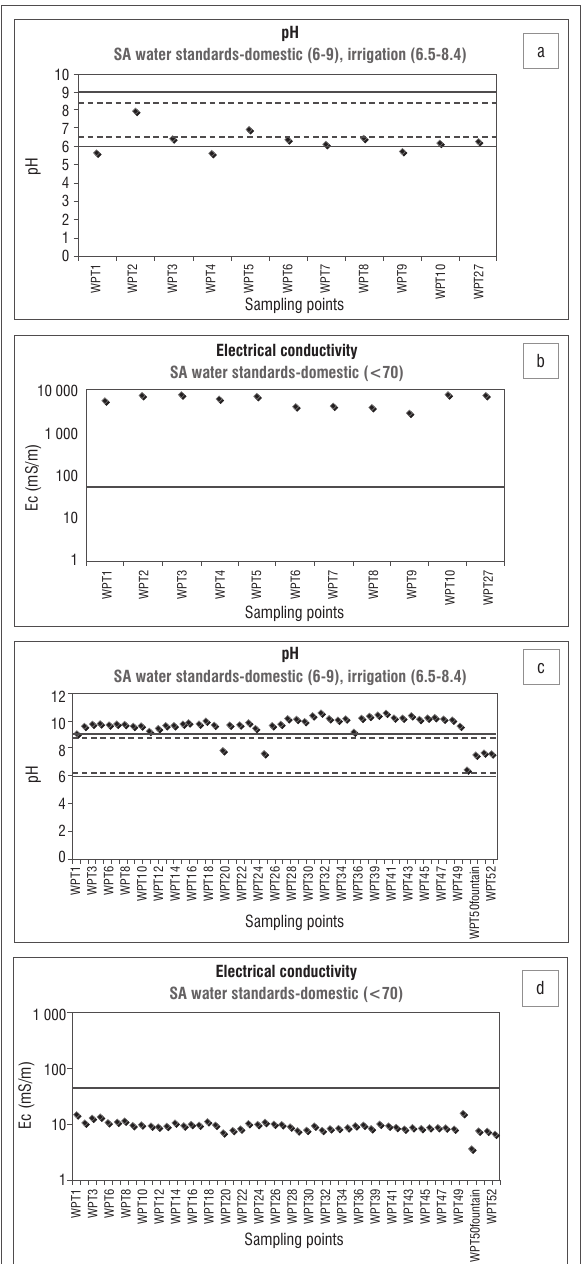
Figure 2: Variation in pH in (a) March 2011 and (c) October 2011 and in electrical conductivity (EC) in (b) March 2011 and (d) October 2011 in Bonsma Dam. Lines indicate the target water quality range for domestic ( ) and irrigation ( ) use as set by the Department of Water Affairs and Forestry 17 . Nutrients, mainly nitrogen and phosphorous, are applied to croplands in the form of fertilisers to promote plant growth. An excessive amount of these nutrients can cause water quality problems when entering water systems. 22,23 Analysis of the water samples from the dam showed that the concentrations of nitrogen, potassium and phosphorous were within the Target Water Quality Range for domestic, irrigation and aquatic ecosystem use. A water body is rendered eutrophic when the concentration 17 of nitrate ranges from 2.5 mg/L to 10 mg/L. Nitrate concentrations in the dam remained below 2.5 mg/L in the wet and dry seasons, except at three sampling points (WPT 6, 7 and 8) at which nitrate concentrations were above 2.5 mg/L in the wet season. The three sampling points, seen in Figure 3, were along inlet streams that feed